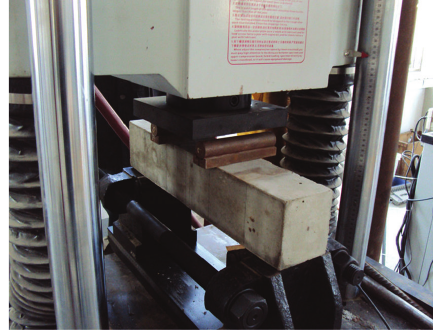
Figure 2: Picture of test setup for four-point loading.